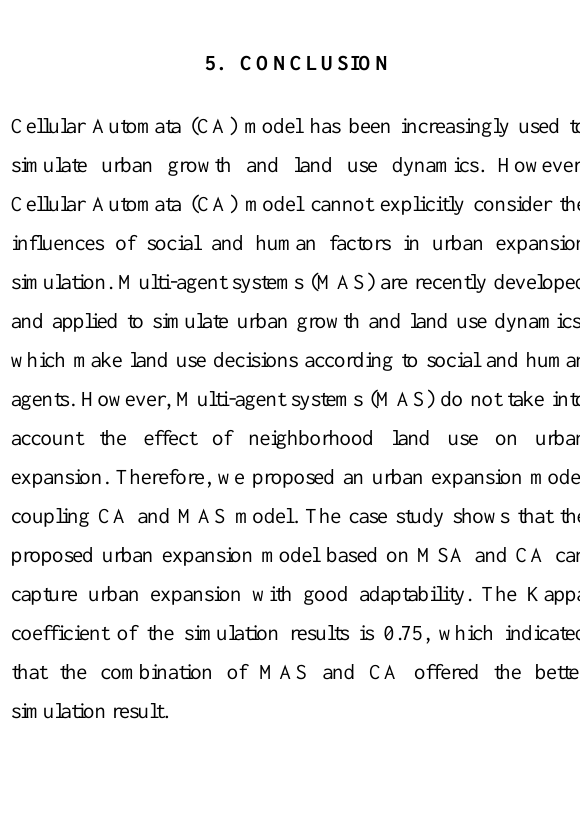
Figure 2 urban land use in 2010 (a) real; (b)